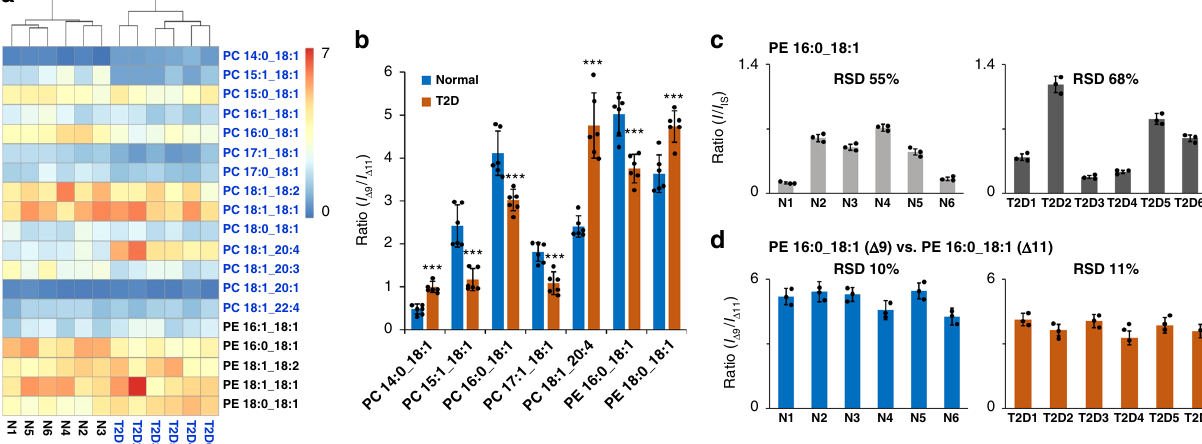
Fig. 4 Analysis of GPs containing C18:1 Δ 9/ Δ 11 isomers in human plasma samples. a Hierarchical cluster analysis of I Δ 9 / I Δ 11 in normal (N1 – N6) and T2D plasma samples (T2D1 – T2D6) provides correct grouping of the two sets of samples. Colors represent different ratios as indicated by the color bar. b Seven pairs of lipid isomers (C18:1 Δ 9/ Δ 11) are found to exhibit signi fi cant changes in relative composition ratios between normal control and T2D. Differences between the two groups were evaluated using the two-tailed student ’ s t test (*** P <0.001). Each value represents the mean± s.d. ( N = 6). c , d Comparisons of individual-to-individual variations based on c relative quantitation ( I / I IS ) of PE 16:0_18:1 and d relative isomer ratio ( I Δ 9 / I Δ 11 ) measurement of PE 16:0_18:1 in normal and T2D plasma samples. Each value represents the mean± s.d. ( N = 3). Precision of relative isomer ratio measurements is much less affected by individual-to-individual variations as compared to relative quantitation measurements at subclass